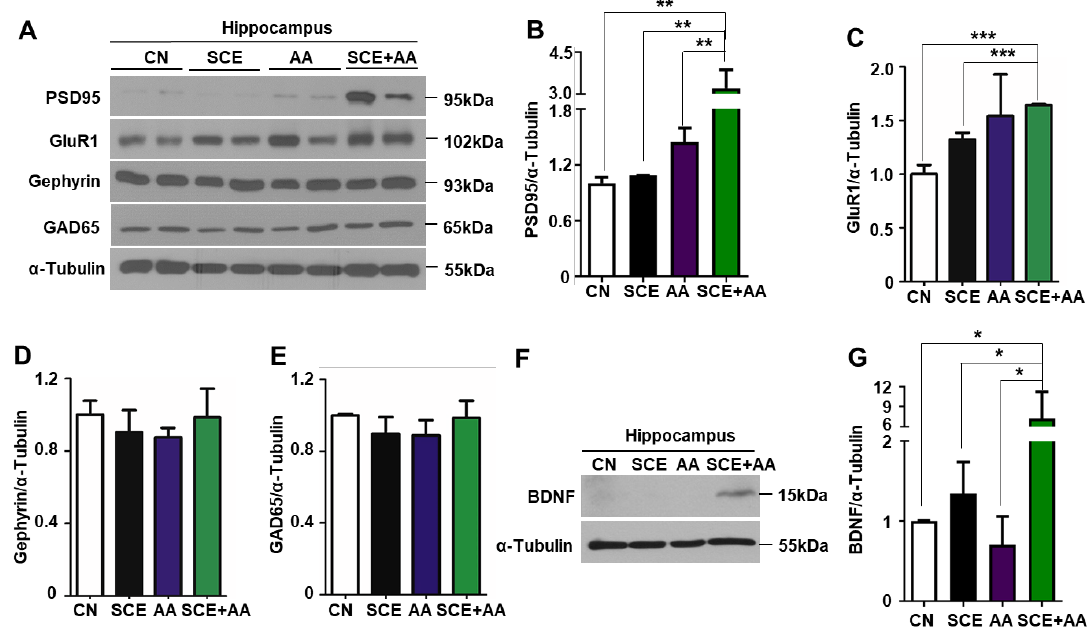
Figure 4. Hippocampal postsynaptic density protein 95 (PSD95) level is increased in mice injected with SCE-AA mixture. ( A ), ( F ), C57BL/6 mice were intraperitoneally injected three times with SCE, AA, or an SCE and AA mixture (10 mg/kg). After behavioral tests, mice were sacrificed and total hippocampal protein was extracted and analyzed by Western blotting. ( B–G ), PSD95, GluR1, gephyrin, glutamic acid decarboxylase 65-kilodalton isoform (GAD65), and brain-derived neurotrophic factor (BDNF) protein expression levels were measured using ImageJ. Values are presented as means ± SD of triplicate samples (* p < 0.05, *** p < 0.001 vs. corresponding controls).